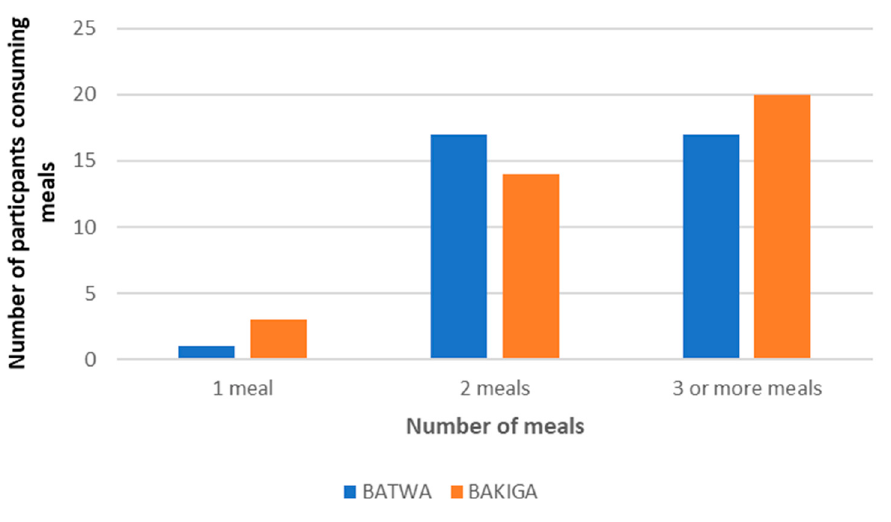
Figure 3. Number of meals among Batwa and Bakiga participants.